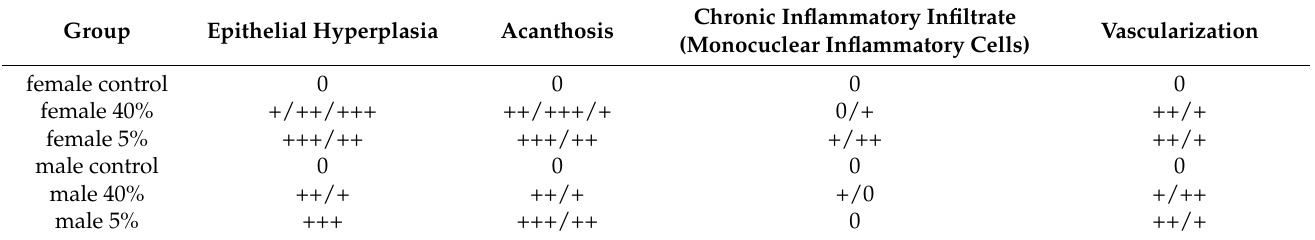
Table 2. Histological changes in the cheek mucosa in rats after weekend alcohol consumption for 3 months.